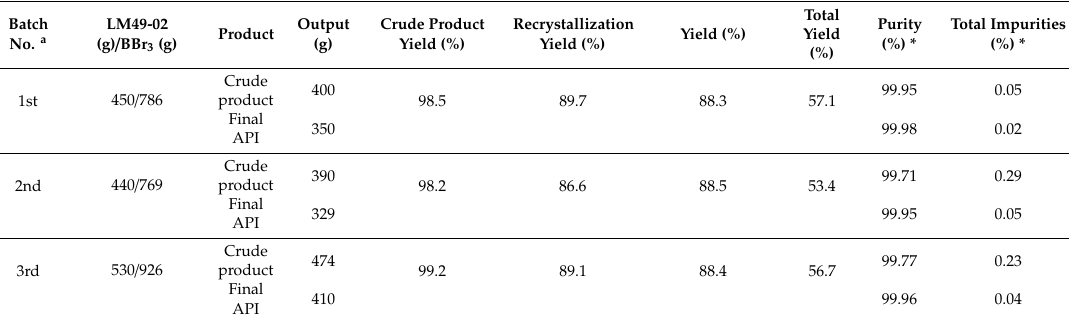
Table 11. Process validation of LM49-API .